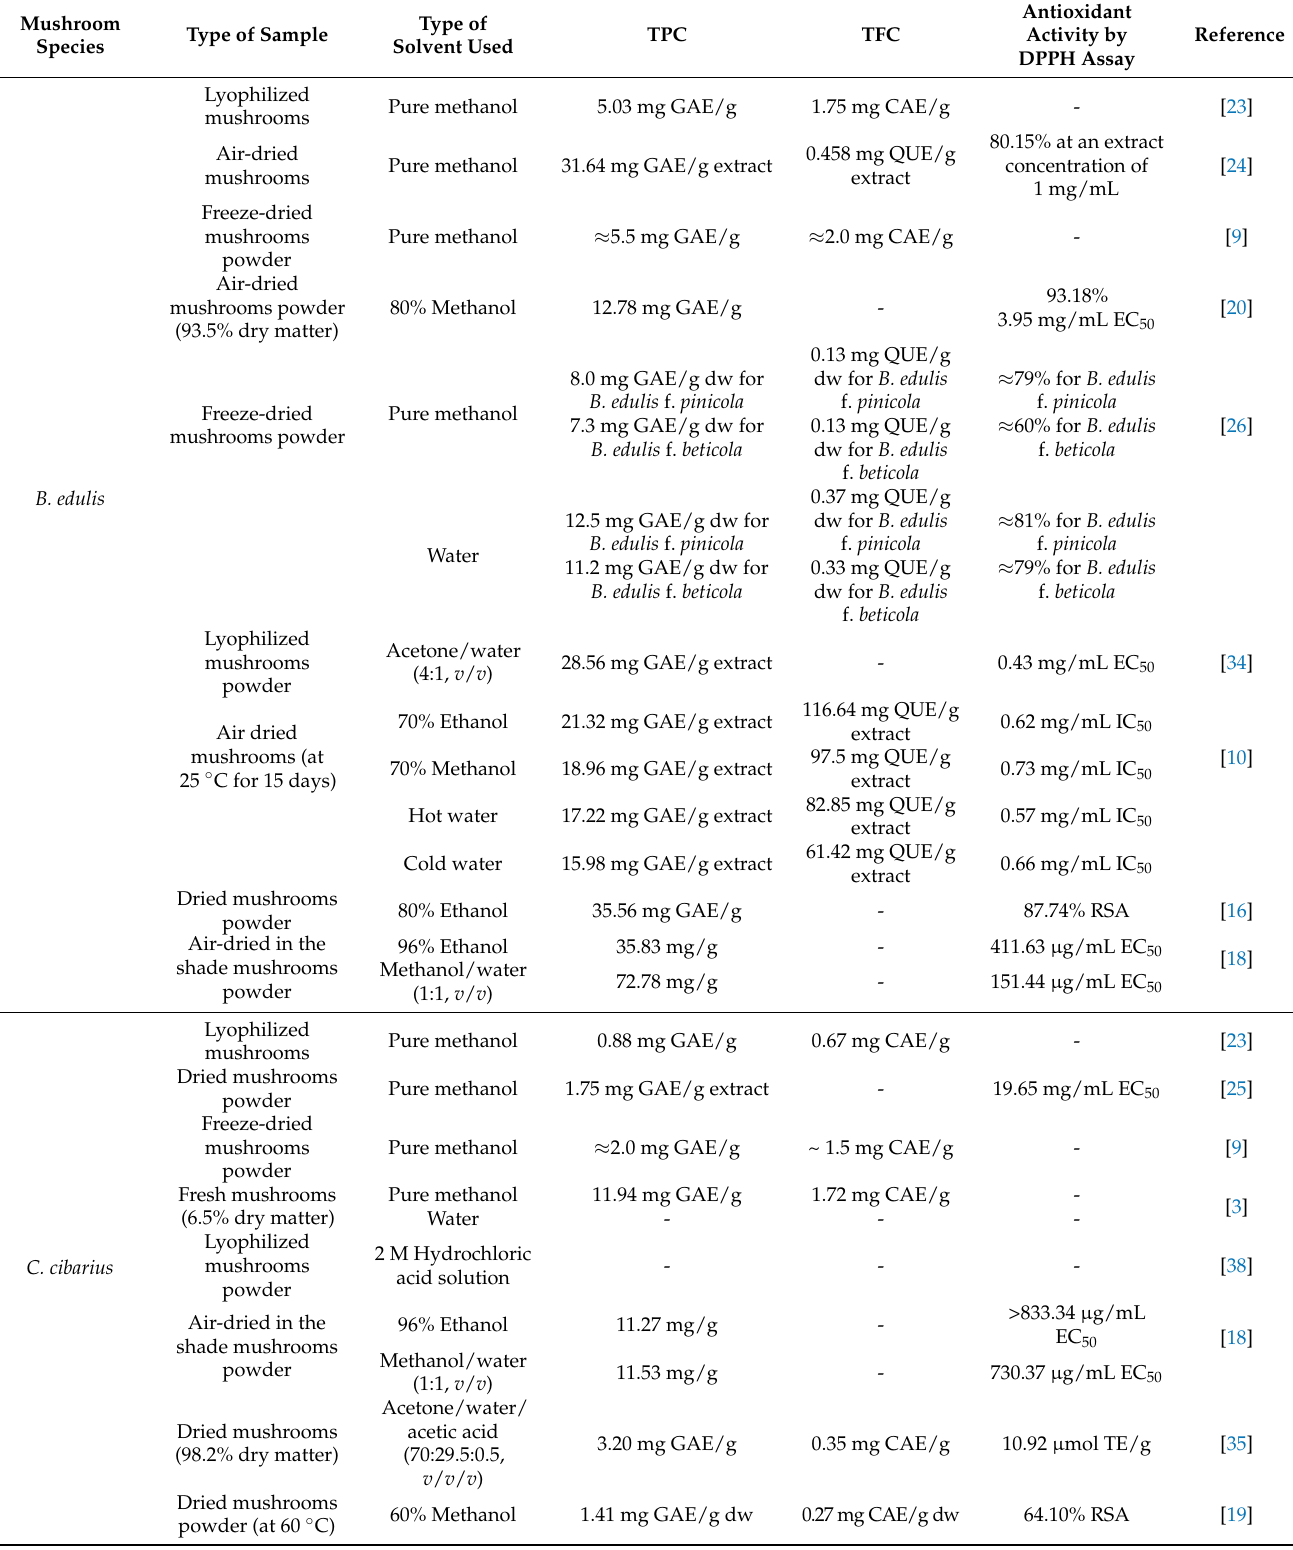
Table 2. Existing literature as data on B. edulis and C. cibarius mushroom